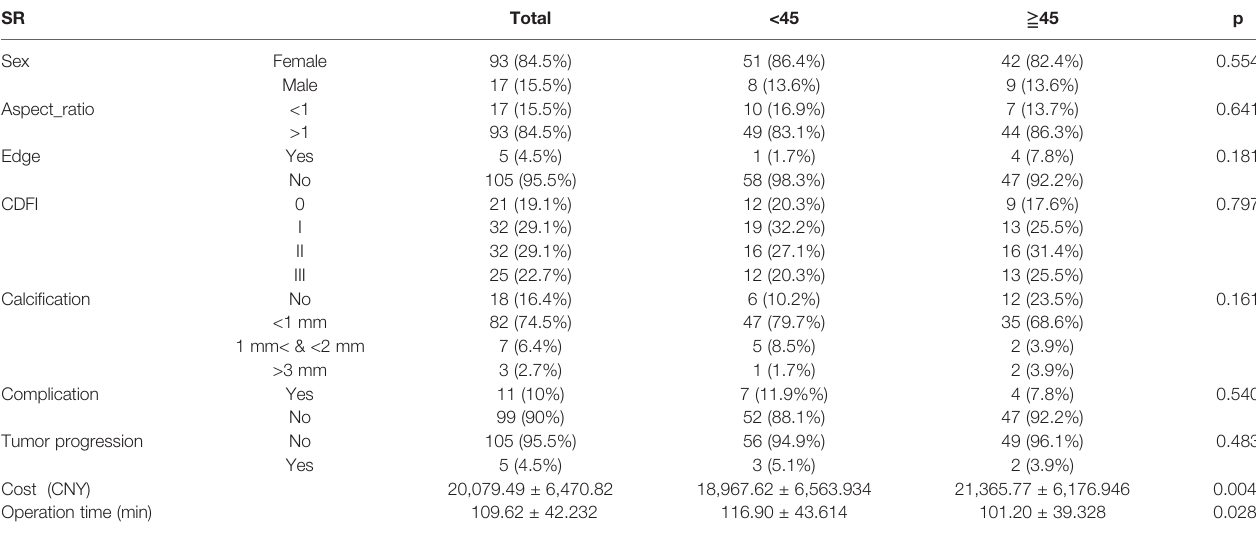
TABLE 4 | Outcomes of surgical resection according to age subgroups.